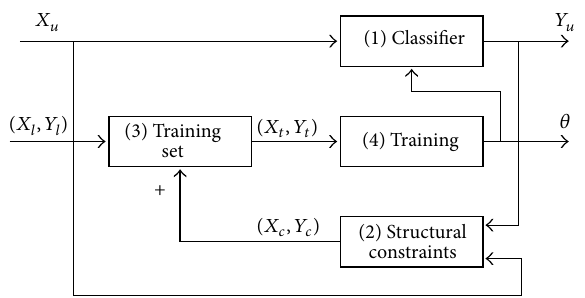
Figure 1: A flowchart in [17] to explain P-N learning. P-N learning algorithm initially develops a classifier from prior knowledge